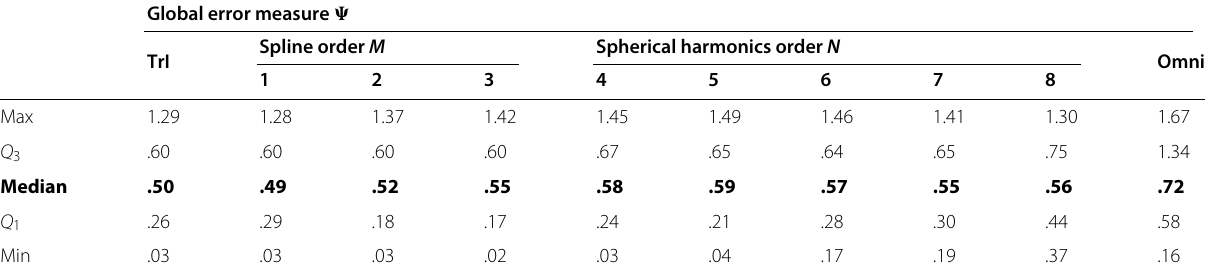
Table 1 Distribution of the global error measure (cid:9) for the examined interpolation methods triangular (TrI), spline (for M = { 1, 2, 3 } ), spherical harmonics (SH, for N = { 1, 2, ..., 8 } ), and ordinary omnidirectional assumptions of the directivity (Omni) across all 27 analyzed partial tones Global error measure (cid:2) Spline order M Spherical harmonics order N TrI